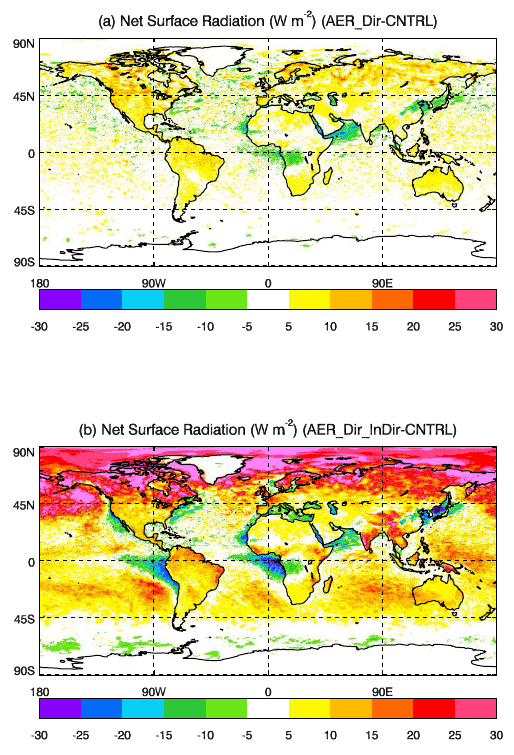
Fig. 11. Radiative impact of aerosol on the net surface radiation at T + 120 from (a) AER_DIR and (b) AER_DIR_INDIR. (mean bias of 18.38 Wm − 2 ) and also the emitted LW up